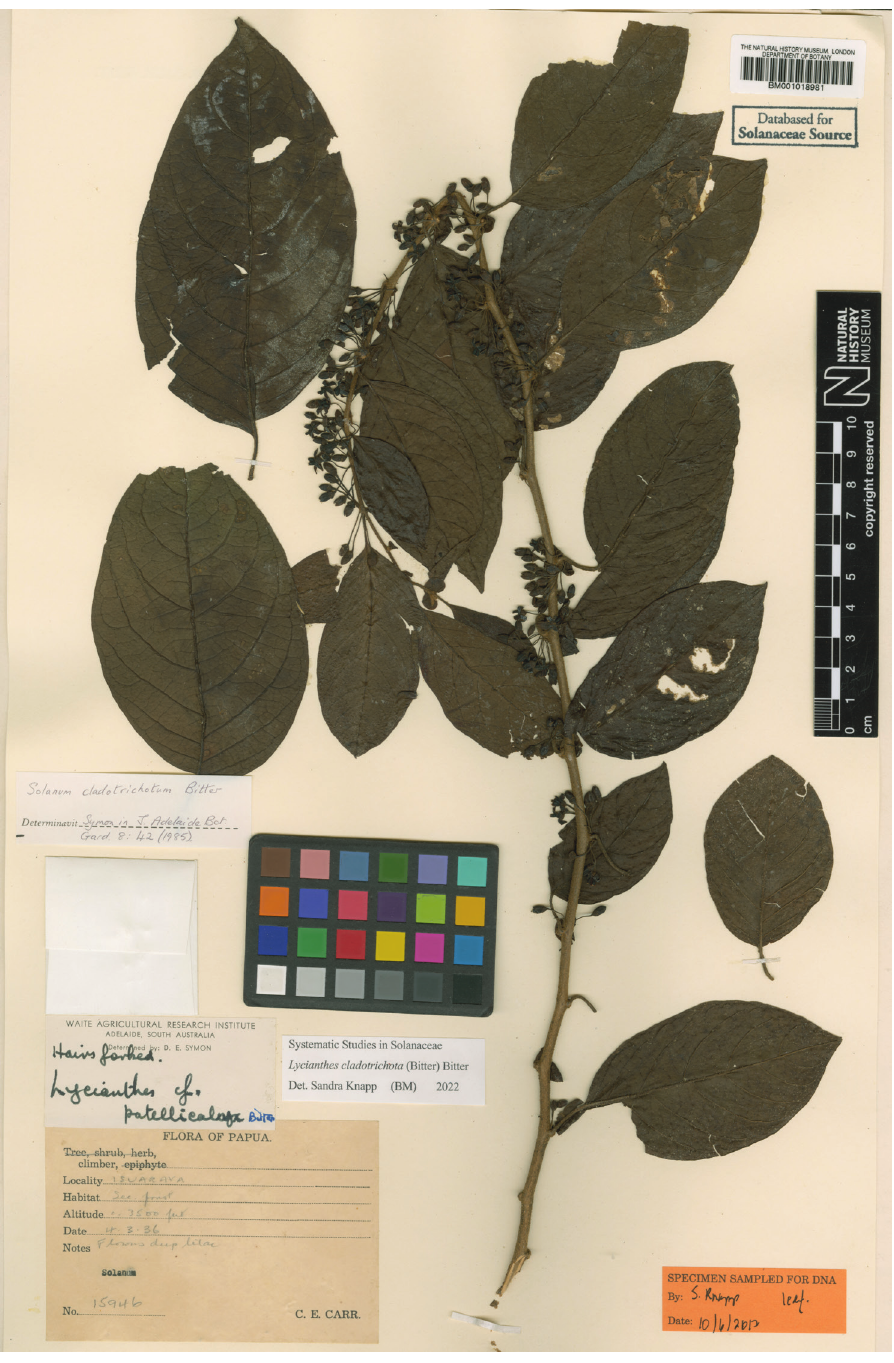
Figure 17. Lycianthes cladotrichota herbarium specimen. Papua New Guinea. Oro: Carr 15946 (BM001018981). Courtesy of the Trustees of the Natural History Museum, London, reproduced with